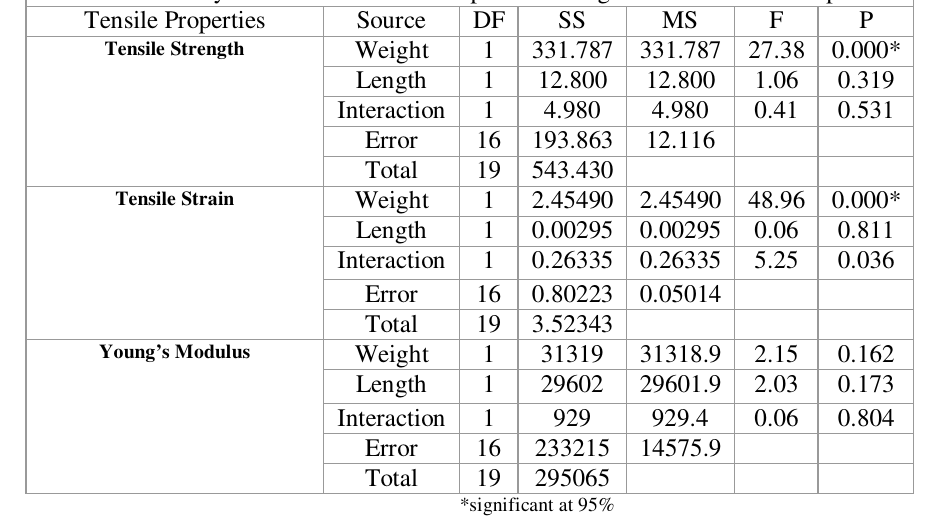
Table 3: Two way ANOVA of Tensile Properties of Bagasse-Reinforced Composites Tensile